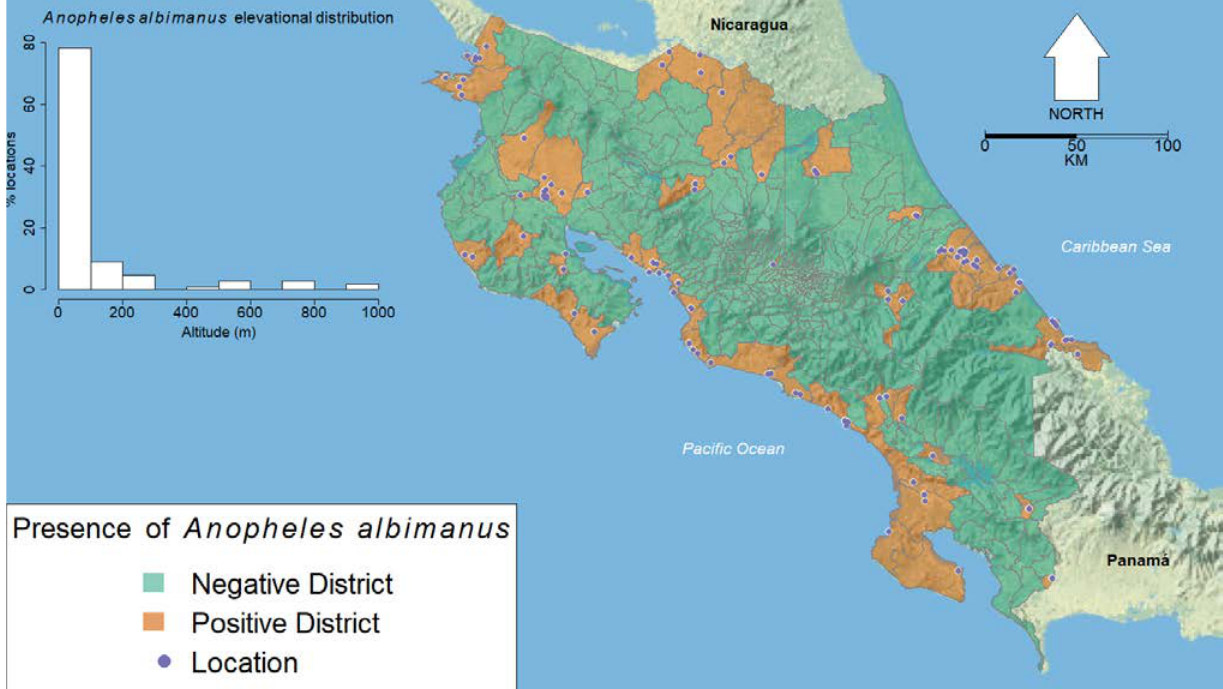
Figure 1. Map showing the distribution of Anopheles albimanus record locations; divisions indicate the districts of Costa Rica. The inset histogram shows the distribution of elevations from locations where An. albimanus has been sampled. The inset legend indicates symbols and color coding for the presence of An. albimanus. The vector file for the districts of Costa Rica is from Costa Rica’s National Geographical Institute [45]. The map used a public domain map from the US National Park Service as its base [46]. An. albimanus has been recorded in all seven provinces of Costa Rica, in 28 out of 83 counties and in 55 out of 487 districts.